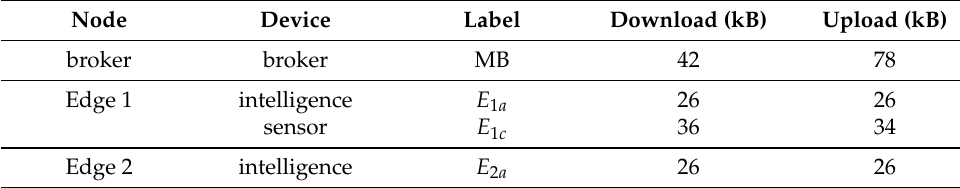
Table 8. Prediction: Network activity.